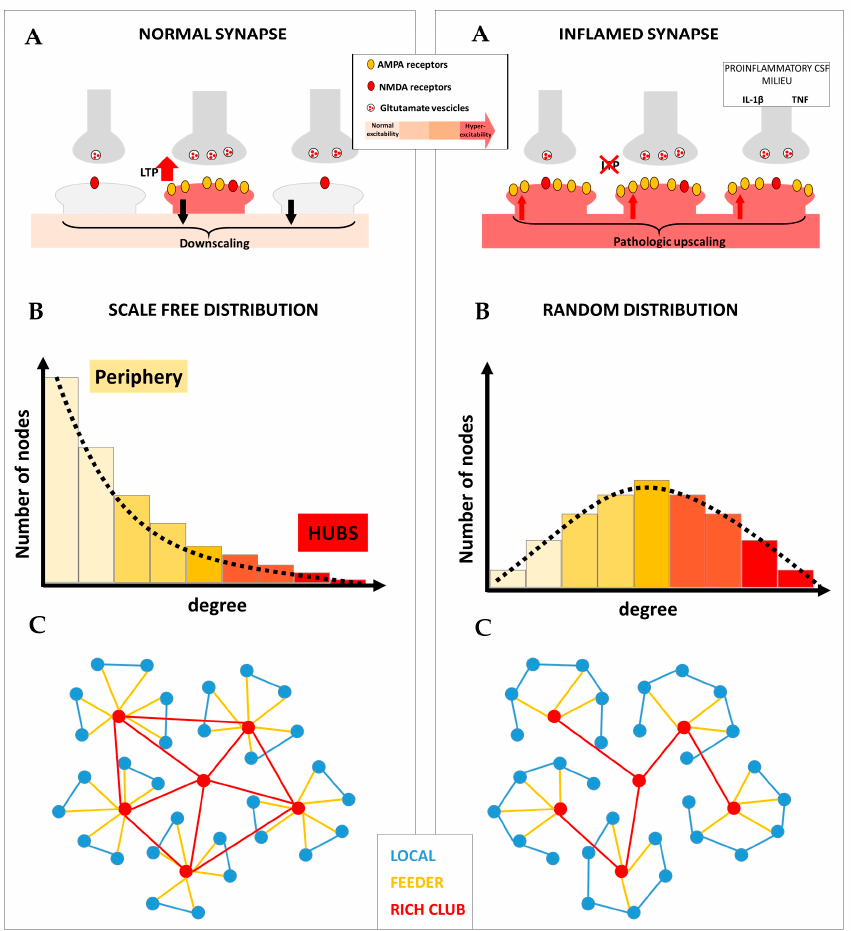
Figure 1. Different forms of synaptic plasticity cooperate to promote optimal brain network topology. Left panel: ( A ) In physiological conditions, the balance between anti-homeostatic and homeostatic plasticity allows the generation of potentiated synapses, associated with selective information processing, and prevents uncontrolled hyperexcitability. ( B ) Long-term potentiation (LTP) may be specifically involved in generating highly connected nodes (hubs); conversely, synaptic downscaling may be useful for maintaining low connectivity in the peripheral nodes of the network. The fine-tuning between these two forms of synaptic plasticity is required to form brain networks characterized by a scale-free degree distribution. ( C ) The resulting brain network architecture is characterized by elevated efficiency of information processing and resilience to random damage. Right panel: ( A ) In multiple sclerosis (MS), neuroinflammation is associated with impaired LTP and pathologically overexpressed synaptic upscaling, leading to uncontrolled neuronal hyperexcitability. ( B ) Disrupted LTP may selectively reduce hub connectivity, while overexpressed upscaling may contribute to increasing connectivity in the periphery. This is associated with loss of optimal brain network architecture as demonstrated by further random degree distribution. ( C ) Loss of LTP may selectively disrupt hub connectivity and rich club organization. Conversely, pathologic upscaling may promote increased local connectivity. The resulting brain network architecture dramatically reduces efficiency and impairs the ability to compensate for ongoing brain damage in MS.